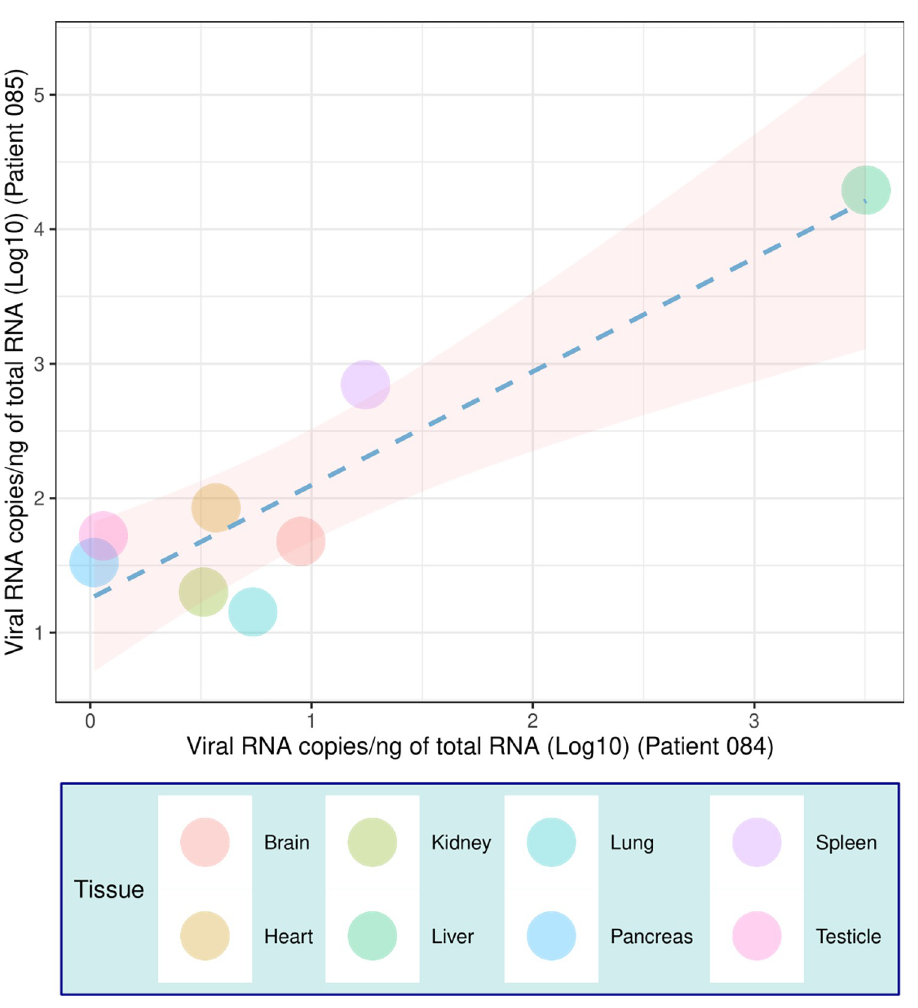
Fig 2. Molecular characterization of the sequenced yellow fever cases, showing the number of YFV RNA copies according to each of the 8 tissues analyzed for positive YFV-sylvatic patients. The different colors represent the different tissues analyzed. The results indicate that both patients present a positive correlation for the quantification of genetic